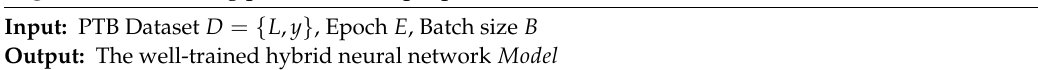
Algorithm 1 Training process of the proposed